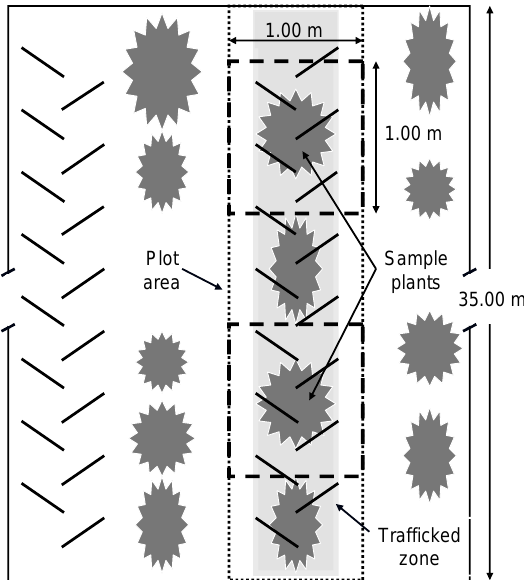
Figure 1. Experiment plot layout (not to scale) with plot area (dotted), sample plants (dashed) and trafficked zone (shaded).